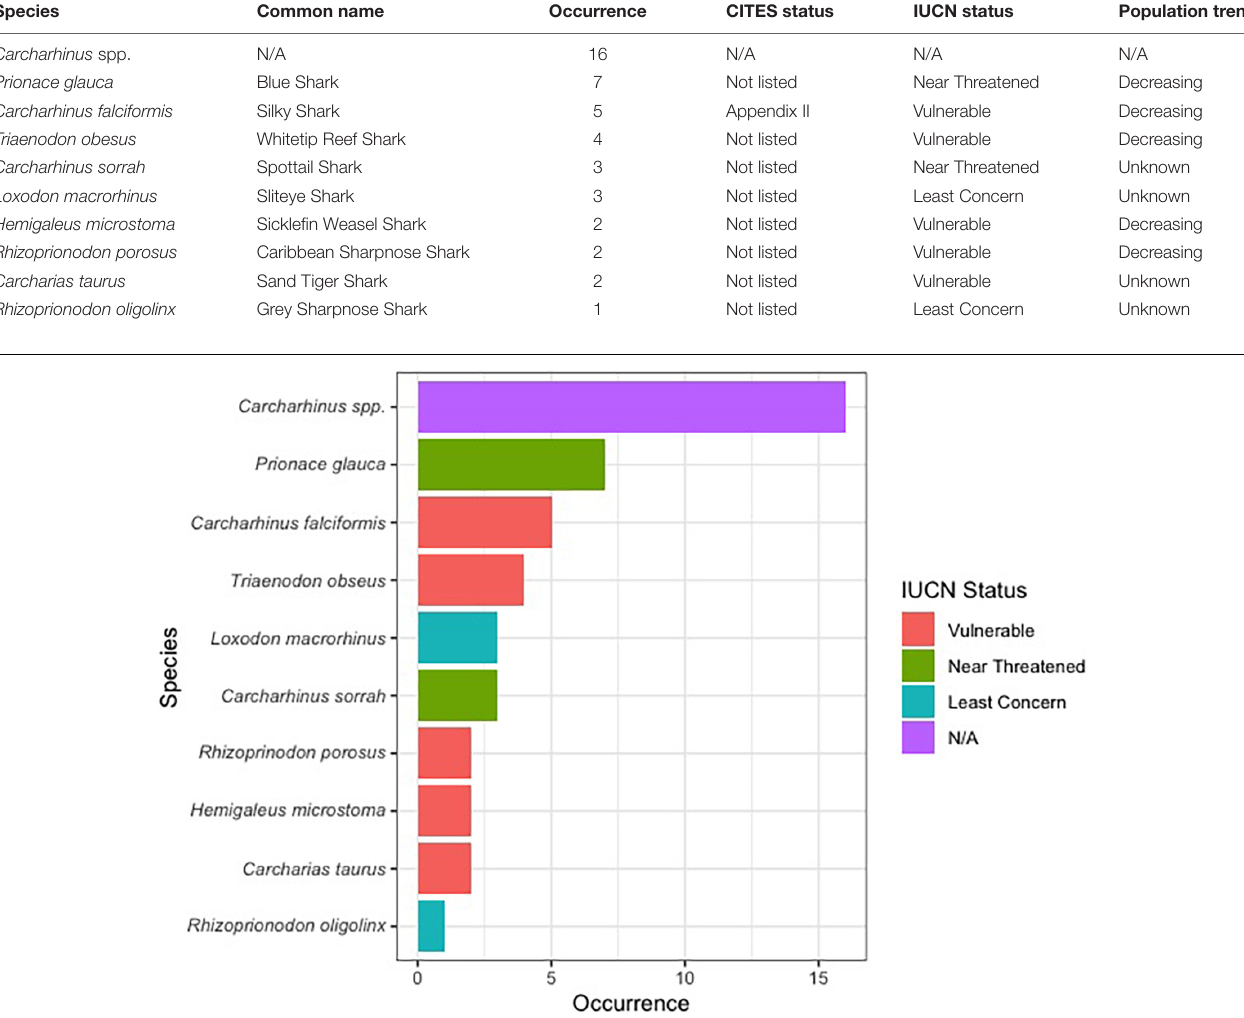
TABLE 1 | Details of species identifications, including occurrence, CITES an IUCN status and the current population tend according to the IUCN Red List. Species